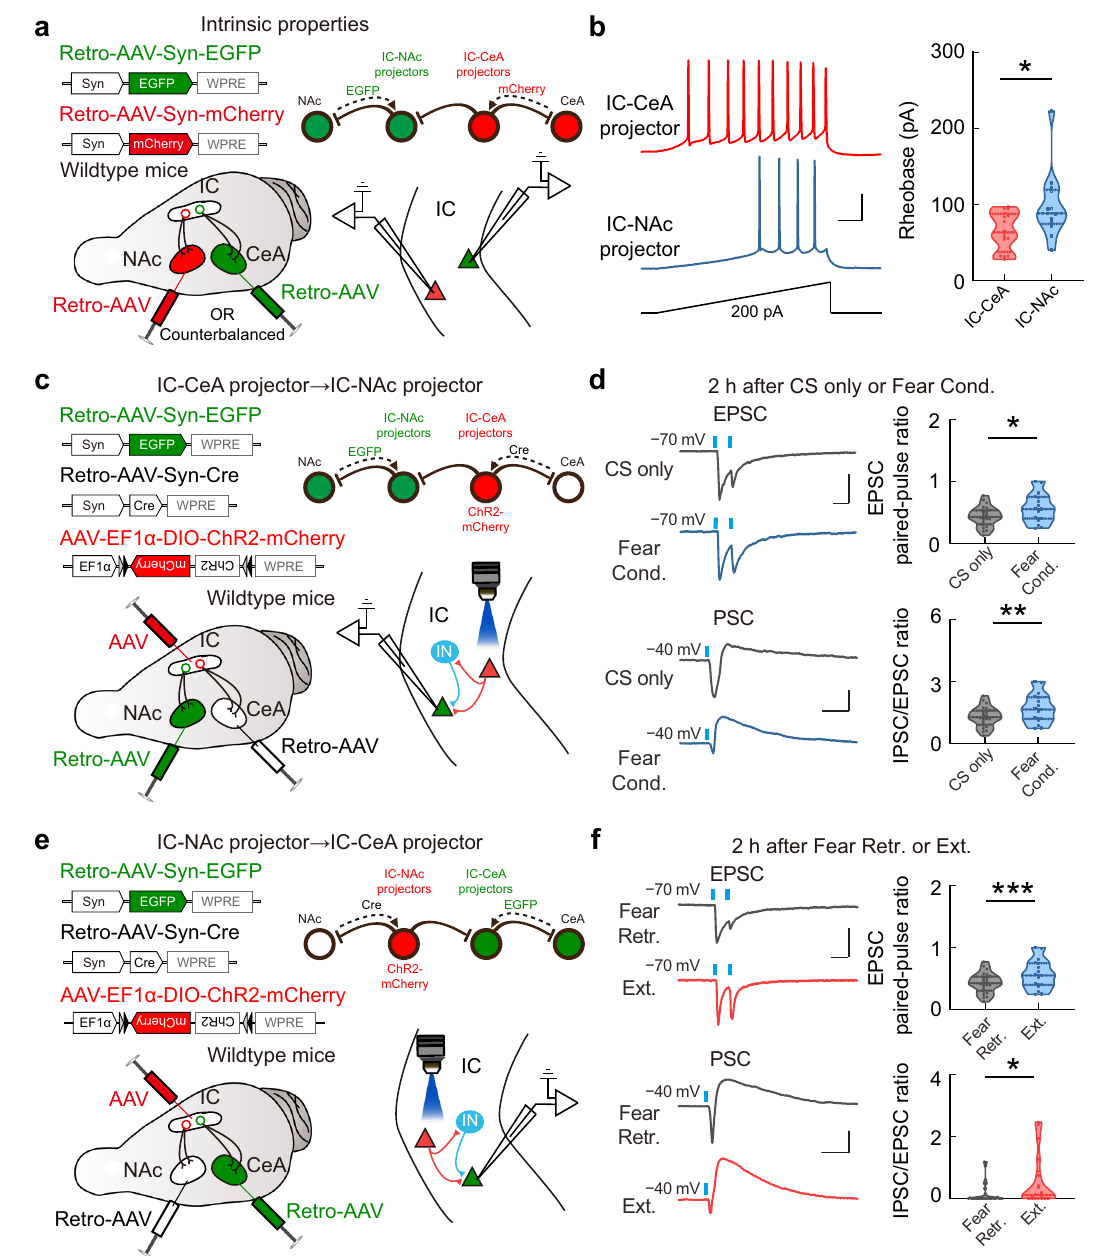
Fig. 6 | Interactions between IC-CeAand IC-NAc projectors in the local circuits changed with fear and extinction memories. a , b Intrinsic electrophysiological properties. a Schematic of slice recordings. b Ramping current injection induced- action potentials. Left: example traces. Scale bars, 50ms, 200 pA. Right: graphic summary. IC-CeA projector, n =16 neurons from 6 mice; IC-NAc projector, n =13 neurons from 7 mice. t (27) =2.572, * P =0.0159, two-tailed unpaired Student ’ s t test. c , d Effectsofactivation ofIC-CeA projectors onIC-NAcprojectors. c Schematicof AAV injections. Whole-cell recordings were made on IC-NAc projectors while acti- vating IC-CeA projectors via blue-light stimuli. d Upper left: example traces of oEPSCs(holding= − 70mV)atthesynapsesfromIC-CeAtoIC-NAcprojectors.Scale bars, 50ms, 200pA. Upper right: statistical analysis of the paired-pulse ratio of oEPSCs. CS only, n =24 neurons from 9 mice; Fear Cond., n =18 neurons from 8 mice. t (40) =2.197, * P =0.0339, two-tailed unpaired Student ’ s t test. Lower left: